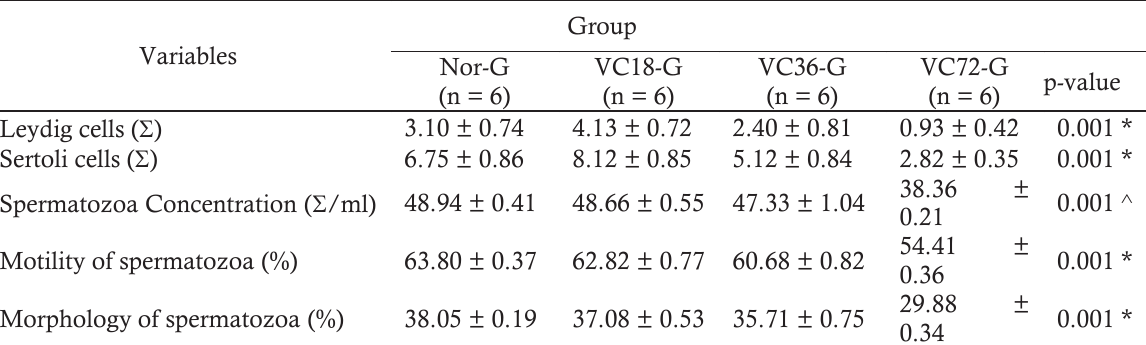
Table 1. Mean of concentration, motility, morphology, number of Leydig, and Sertoli cells count after vitamin C administration